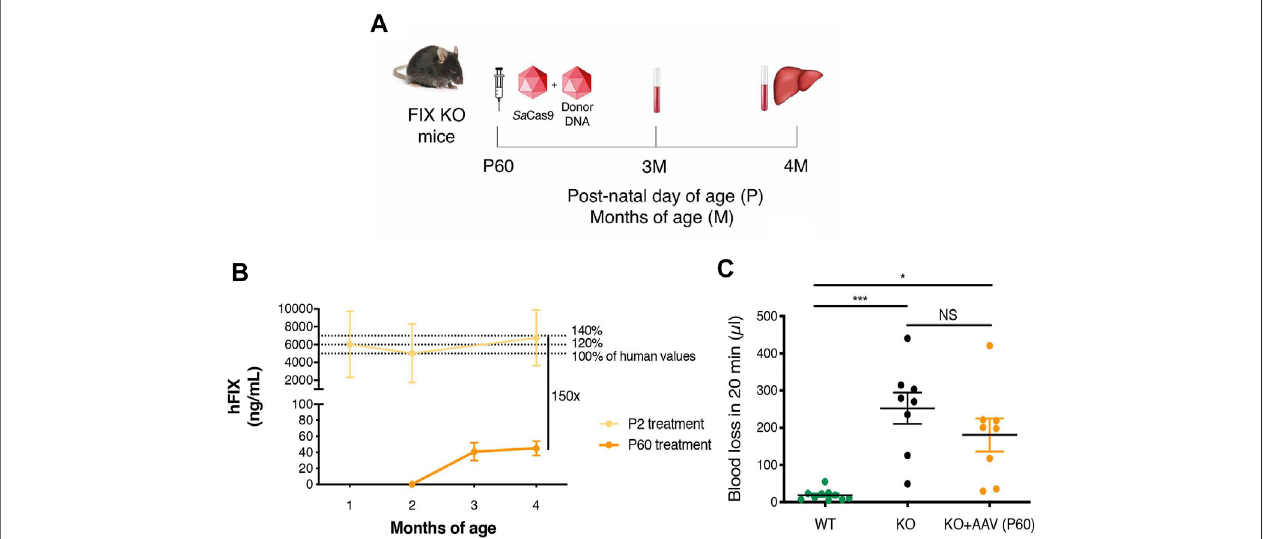
FIGURE 5 | Gene targeting of adult FIX KO mice with gene-targeting strategy coupled to SaCas9. (A) Experimental plan. FIX KO adult mice were injected at 2 months of age (P60) with 1.0E11 vg/mouse of AAV8-SaCas9 and 5.0E11 vg/mouse of AAV8-donor-hFIX. Blood was collected 1 and 2 months after treatment. (B) PlasmahFIX levels in mouse transduced with Sa Cas9 and donor-hFIX at post-natal (P)day 2( n =15) and 60 ( n = 8). hFIX concentration obtained from blood samplesat months 1, 2, and 4 (P2 treatment) and 2, 3 and 4 months (P60 treatment). 5,000 ng/ml corresponds to the normal FIX plasma levels in healthy individuals in the human population. (C) Tail-bleeding assay. Bleeding time was evaluated in treated adult FIX KO mice ( n = 8) and compared to untreated WT ( n = 10) and FIX KO ( n = 8) mice. Data are shown as mean ± SEM and statistically analyzed by one-way ANOVA with Tukey ’ s multiple comparison test.